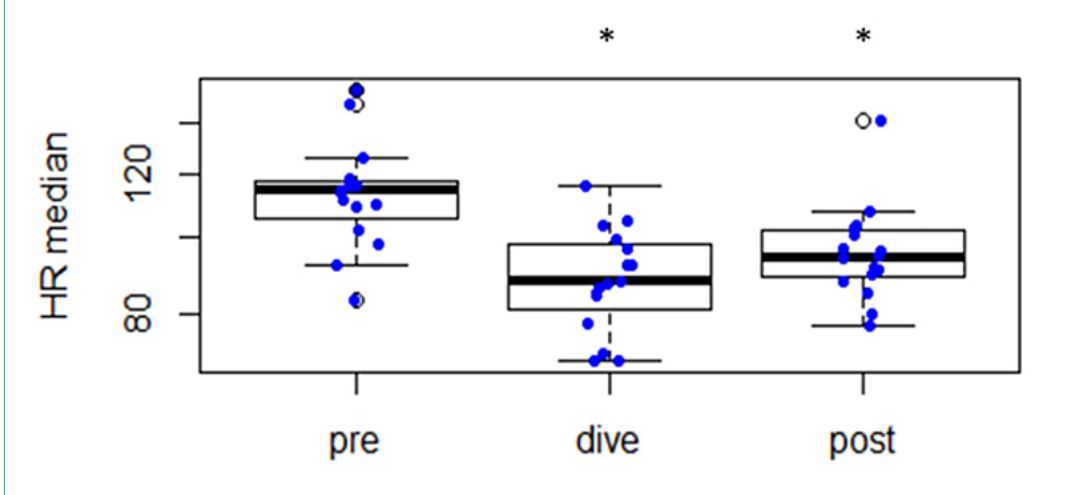
Figure 1: Changes in heart rate before submersion (“pre”), during diving (“dive”) and after resurfacing (“post”). * Statistically significant differ- ent (p <0.05) from “pre”.